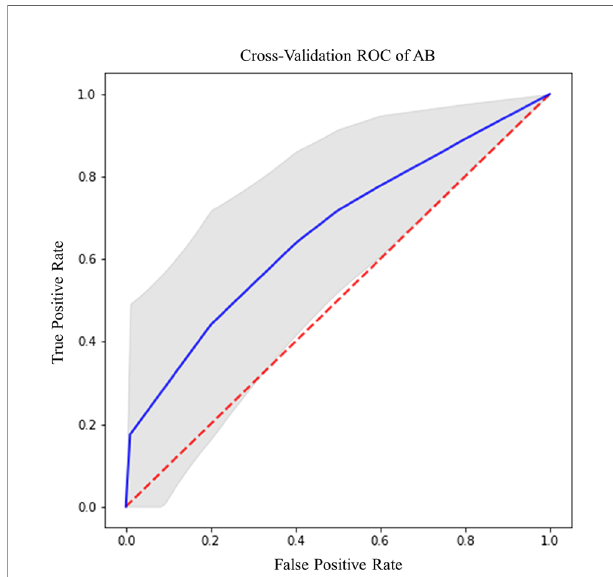
FIGURE 4 | Best ROC curve for MGMT prediction: AB classi fi er with FLAIR sequence on CET ROI.